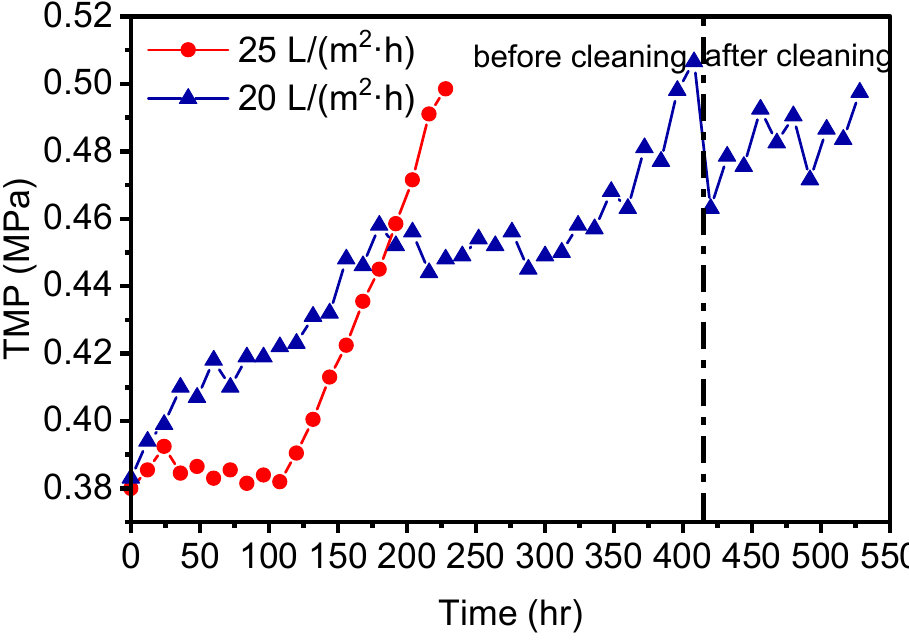
Figure 5. Example TMP variation curves of the pilot-scale NF process at two different fluxes of 20 and 25 L/(m 2 ·h). The TMP data were obtained during the period November–December 2020.